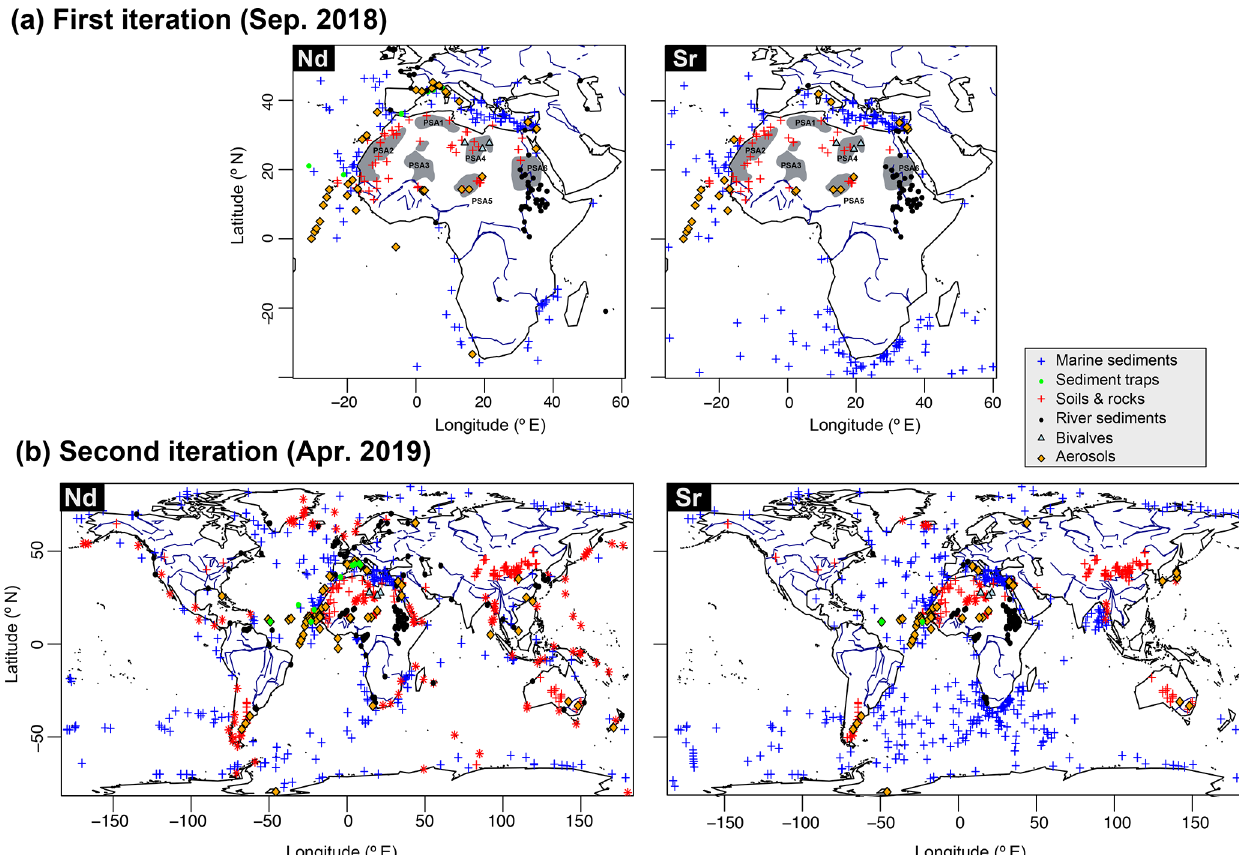
Figure 1. Overview of the location of samples assembled in the database for neodymium and strontium isotope ratios. The sample types are indicated by different markers: blue crosses for marine sediments, green dots for sediment traps, red crosses for soil samples, black dots for river sediments (river banks or particulate matter), blue triangles for fossil bivalves (Osborne et al., 2008) and yellow diamonds for deposited dust samples. (a) Dataset assembled for the first iteration published in September 2018. The African PSAs are indicated as grey underlines and were redrawn from Scheuvens et al. (2013). (b) Dataset assembled for the second iteration published in April 2019. A complete list of references is provided in the Supplement to the main dataset